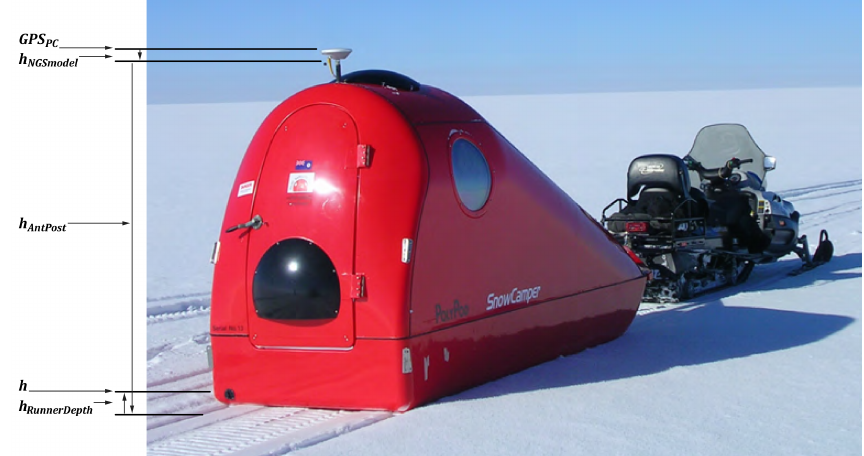
Figure 2. The roving GPS antenna, sled, and snowmobile configuration. GPS PC is the surveyed position solution to the phase center of the antenna, h NGSmodel is the NGS model distance between the antenna phase center and the antenna base plane, h AntPost is the height of the antenna post (Table 1), h RunnerDepth is the depth of the sled runners in the snow surface (Table 1), and h is the snow surface (Eq. 1). Table 2. Airborne lidar elevation bias and surface measurement precision (in m) relative to ground-based GPS survey data (i.e., lidar eleva- tions minus GPS elevations) using “nearest-neighbor” and “zone”